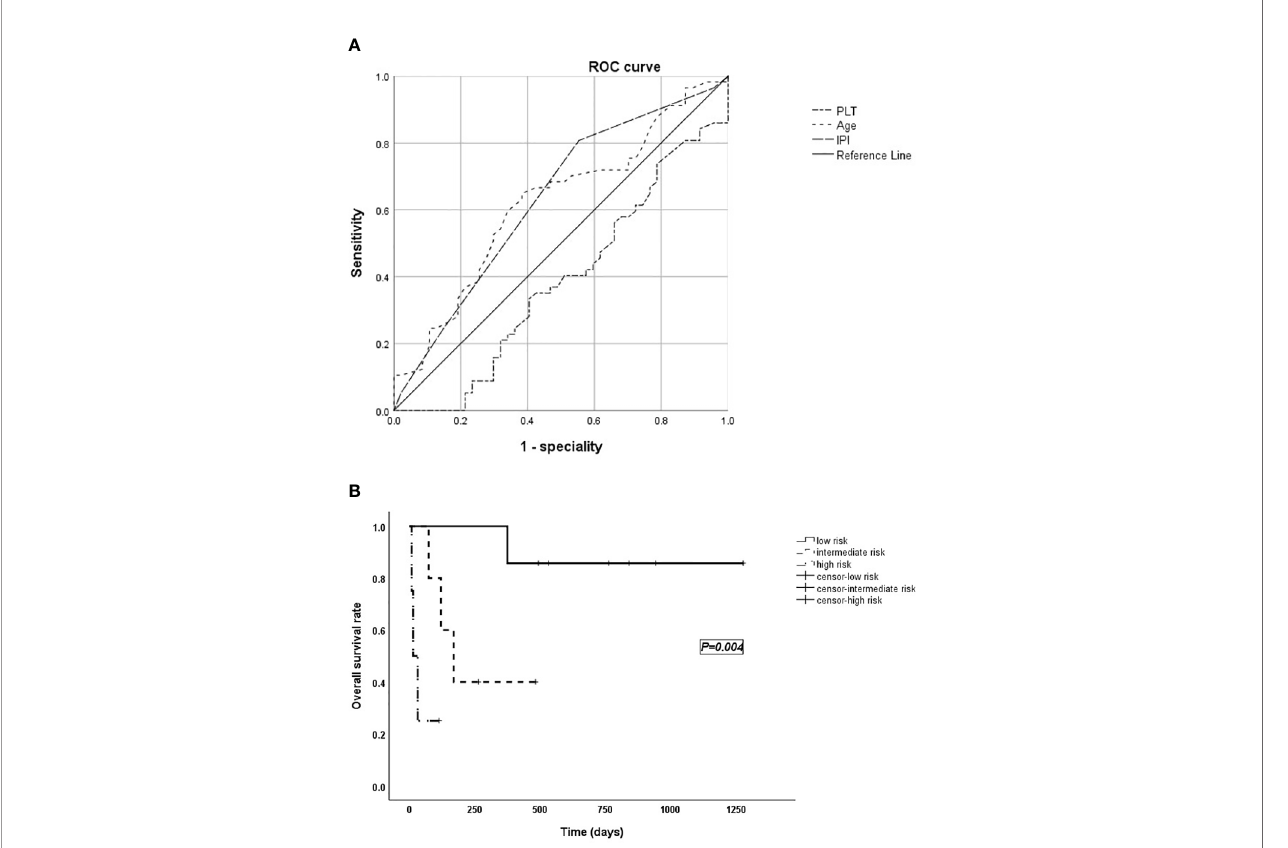
FIGURE 2 | (A) The area under the receiver operating characteristic (ROC) curve used to select bounds for IPI, age, and PLT. (B) Survival curves of the validation